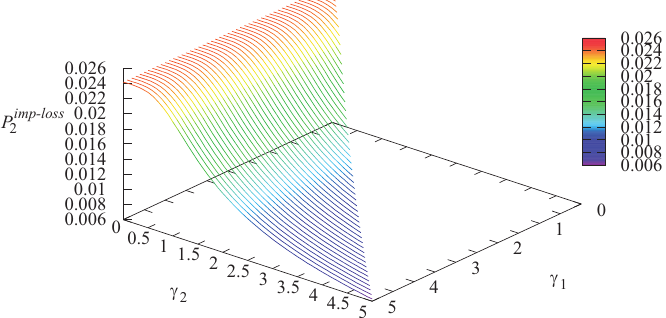
Figure 4. Dependence of the probability P imp impatience in Storage 1 on γ 1 and γ 2 .